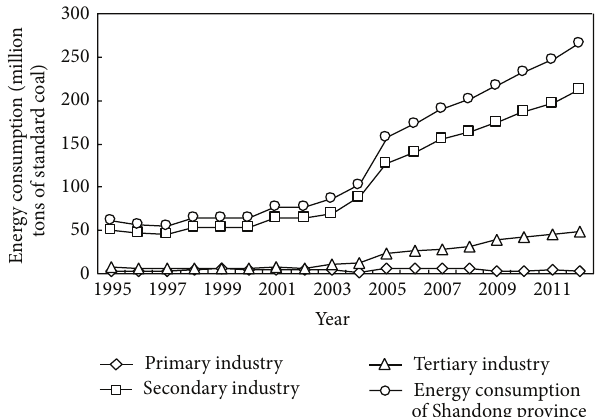
Figure 3: Energy consumption of Shandong province from 1995 to 2012. Source: Shandong Statistics Yearbook 1996–2013.